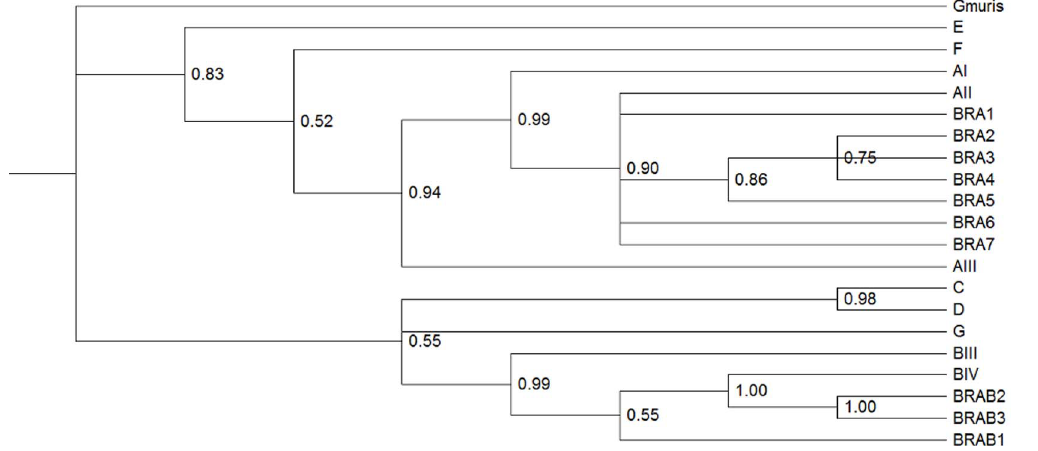
Fig. 3. Phylogenetic relationships of the concatenated bg, tpi, and gdh genes of G. duodenalis . Phylogenetic relationships of G. duodenalis with Bayesian posterior probabilities using a Markov chain Monte Carlo sampling technique. Markov chains were run for 6,000,000 iterations and the trees were sampled every 500 iterations. The GTR model was used with gamma correction. Sequences from G. muris were employed used as an